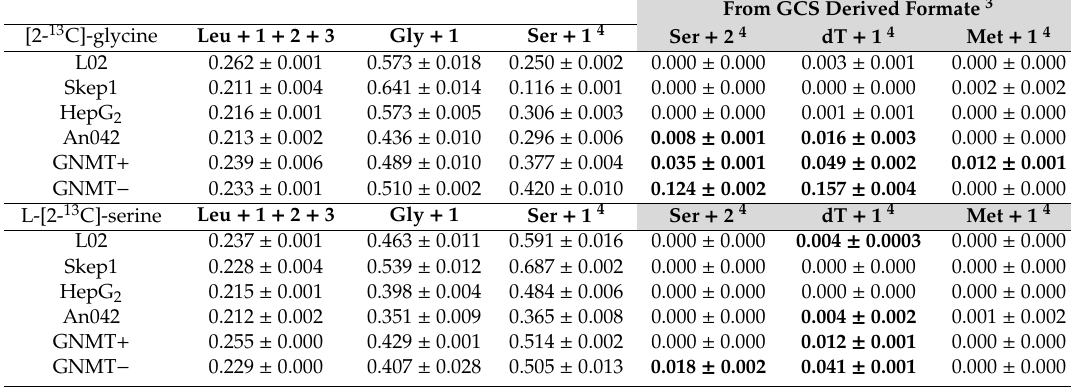
Table 1. Incorporations of carbon-2 from [2- 13 C]glycine and L-[2- 13 C]serine in dTMP, serine, and methionine 1,2 .